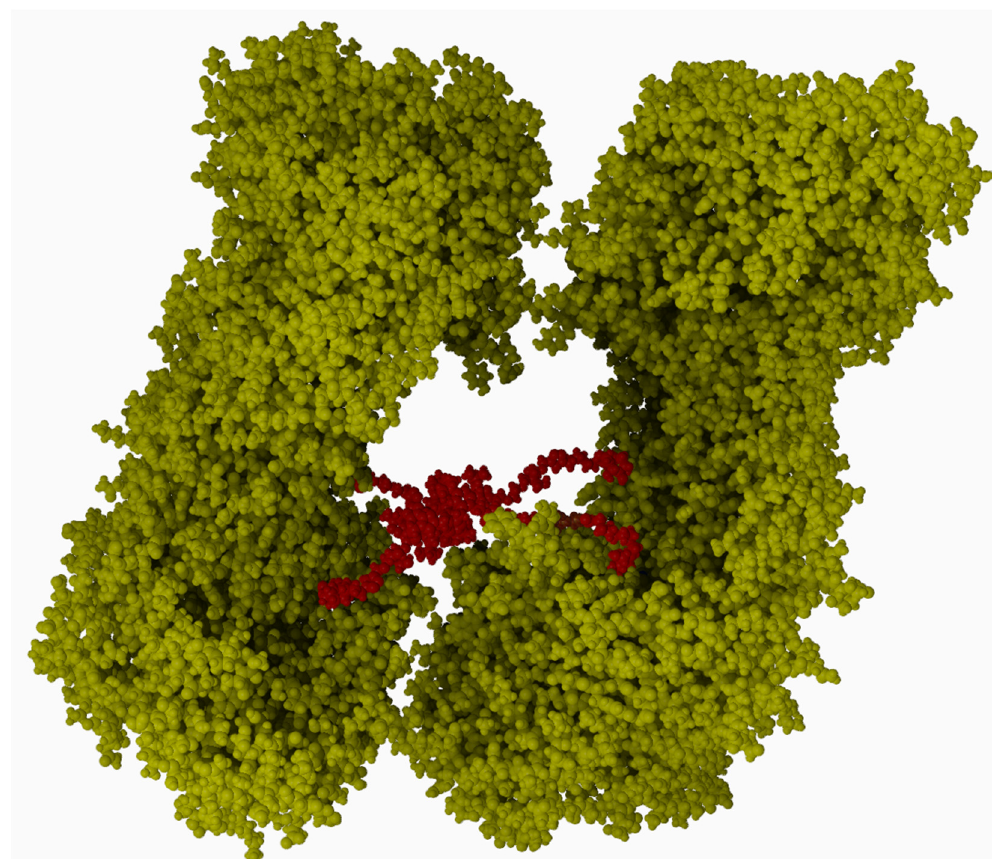
Figure 4. Docking experiments. The 3D model of the octopus-like binding mode of dendritic cluster 6c to JB α -man dimer. The calculation was performed on a simplified cluster model bearing four DNJ heads in order to overcome computing limitations found during the docking calculation with the complete 24-valent cluster 6c.